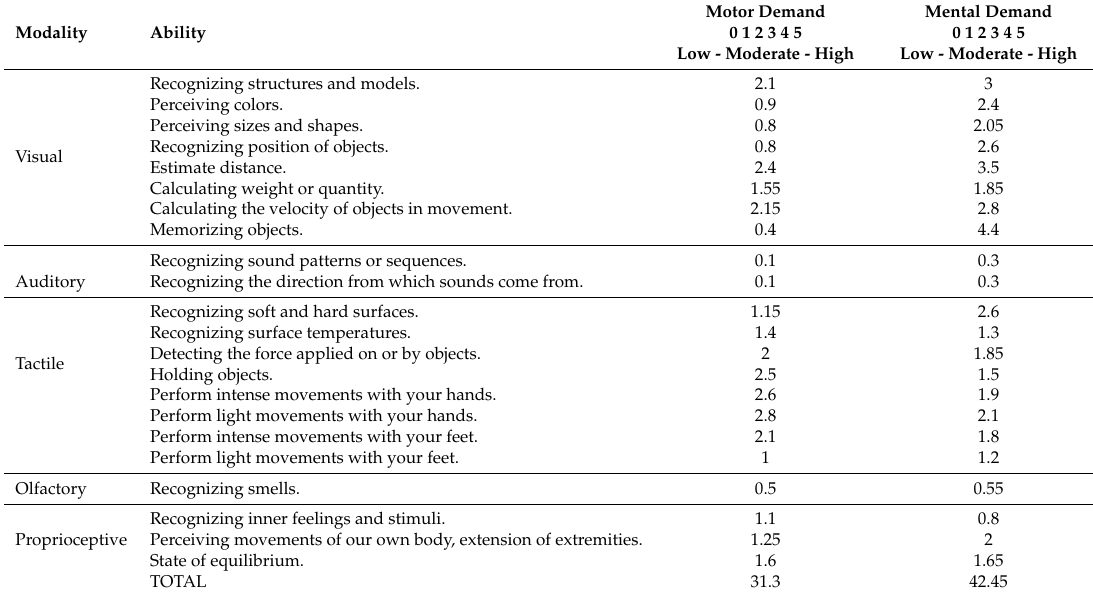
Table 11. Mean for the abilities and demands of Macoli version